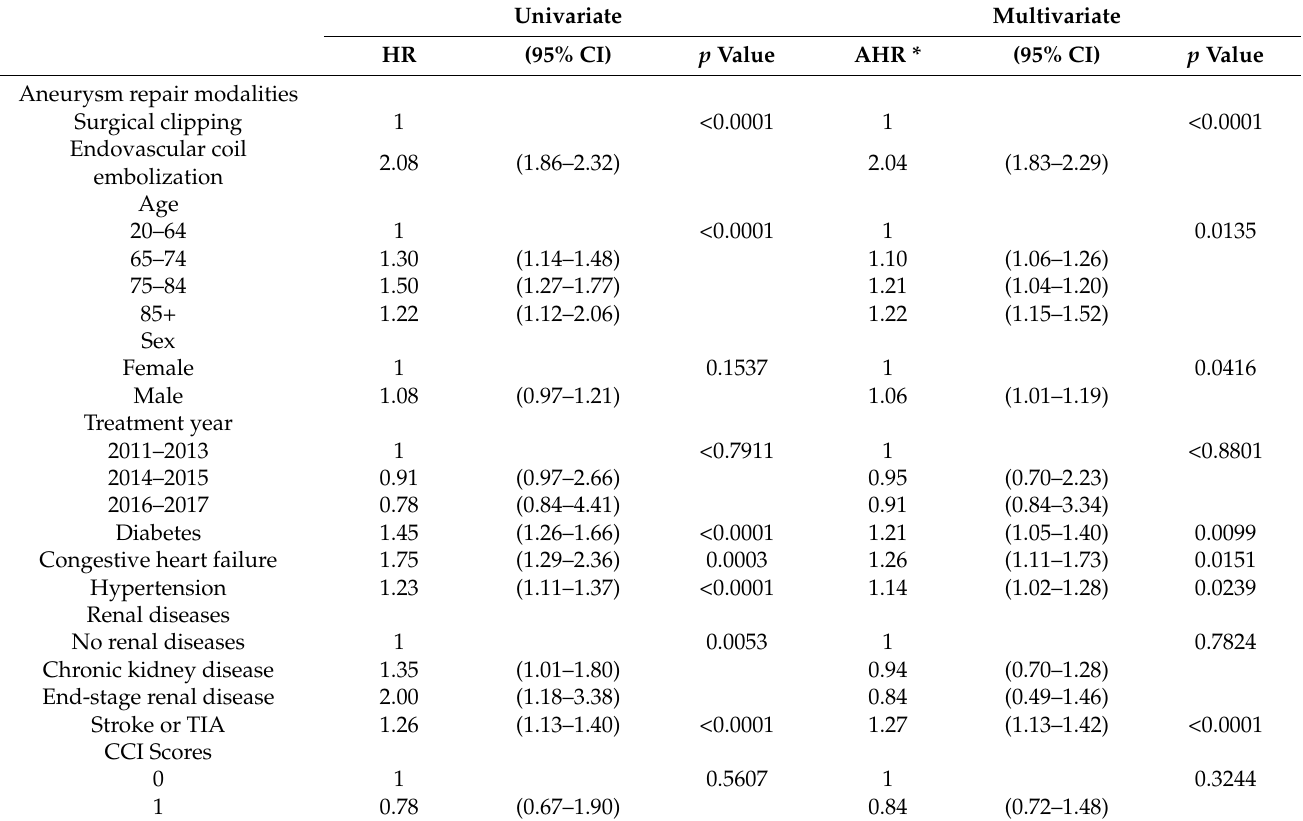
Figure 3. Kaplan–Meier re-stroke-free survival curves of propensity score-matched patients. Table 3. Cox proportional hazards regression analysis of the risk of re-stroke among propensity score-matched patients with ruptured subarachnoid aneurysm undergoing surgical clipping or endovascular